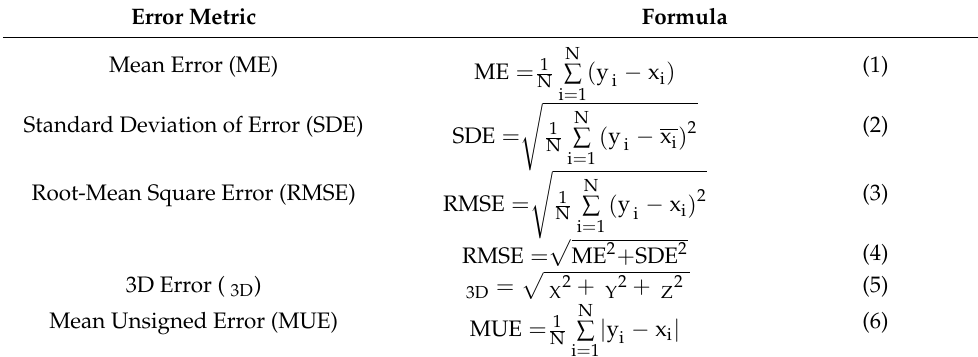
Table 3. Error metrics used for evaluation of measurement